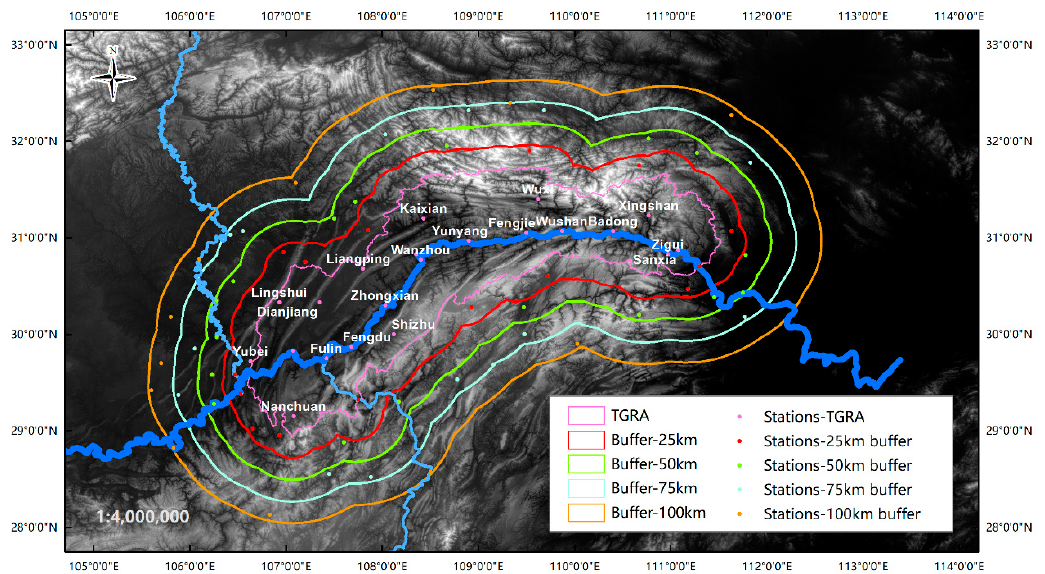
Figure 1. The study area across the Three George Reservoir area (TGRA). The inner most is the TGRA containing 21 meteorological stations. The other four buffering regions are depicted using different colors. The thick blue line depicts the Yangtze River and the thin blue lines depict the branches of the Yangtze River.